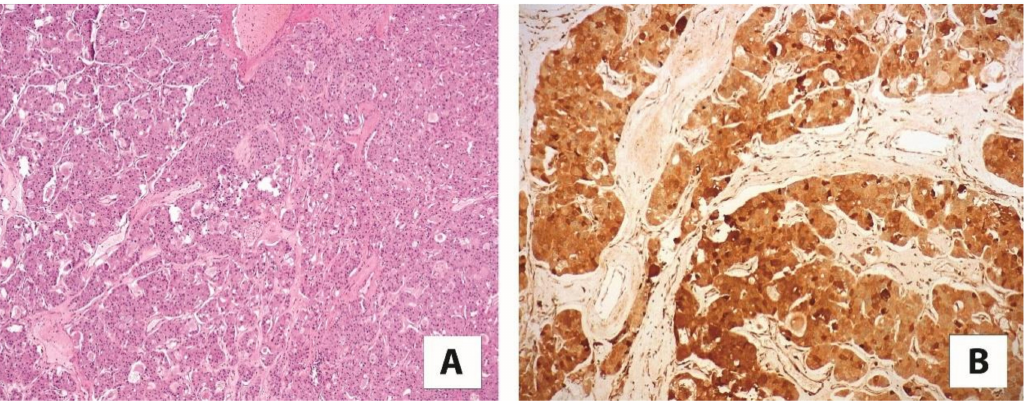
Figure 5. ( A ) A high-grade oncocytic tumor/sporadic renal cell carcinoma with eosinophilic and vacuolated cells (5 × ) ( B ) immunolabelling for cathepsin K (20 ×